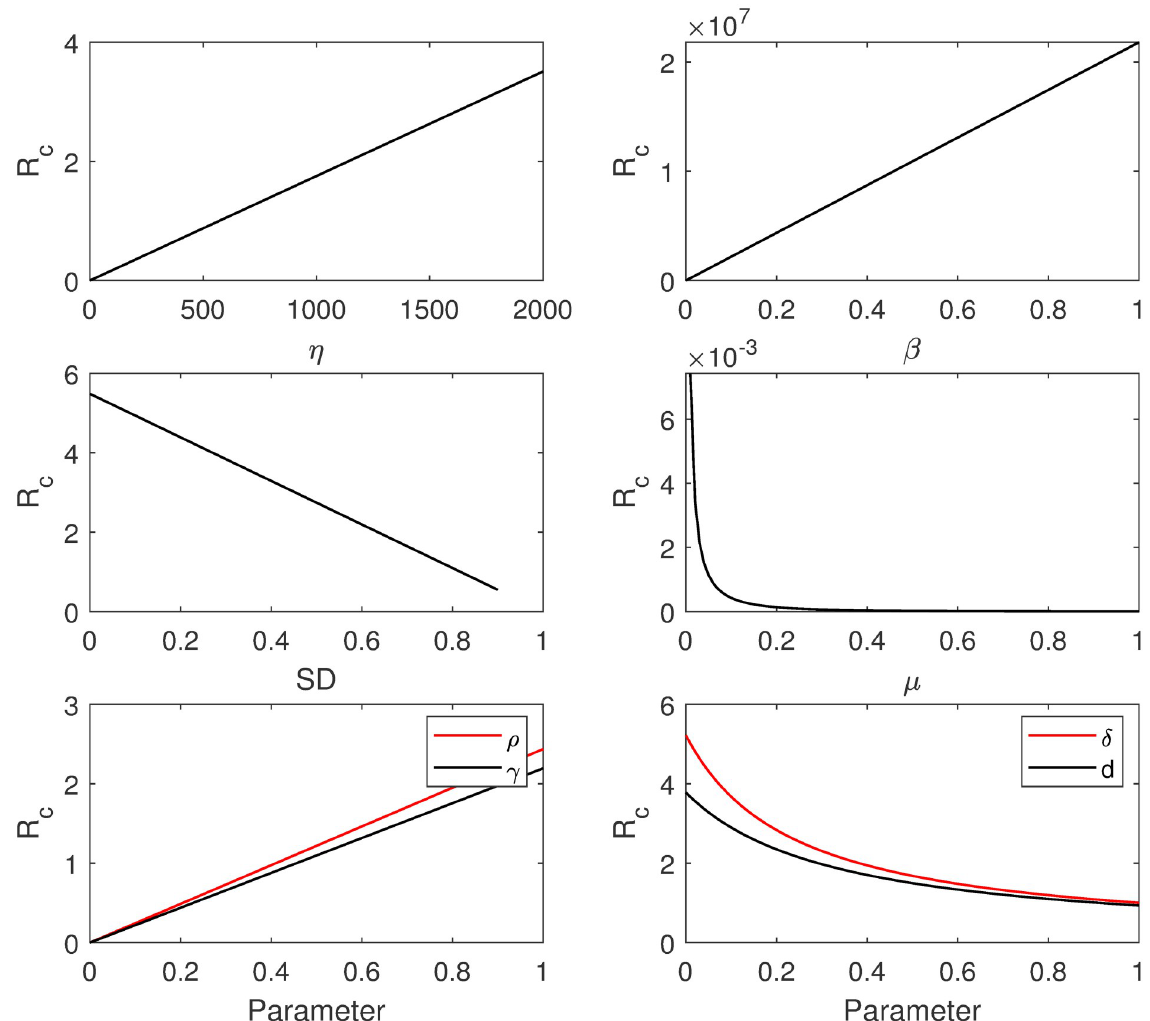
Fig 6. The sensitivity of R